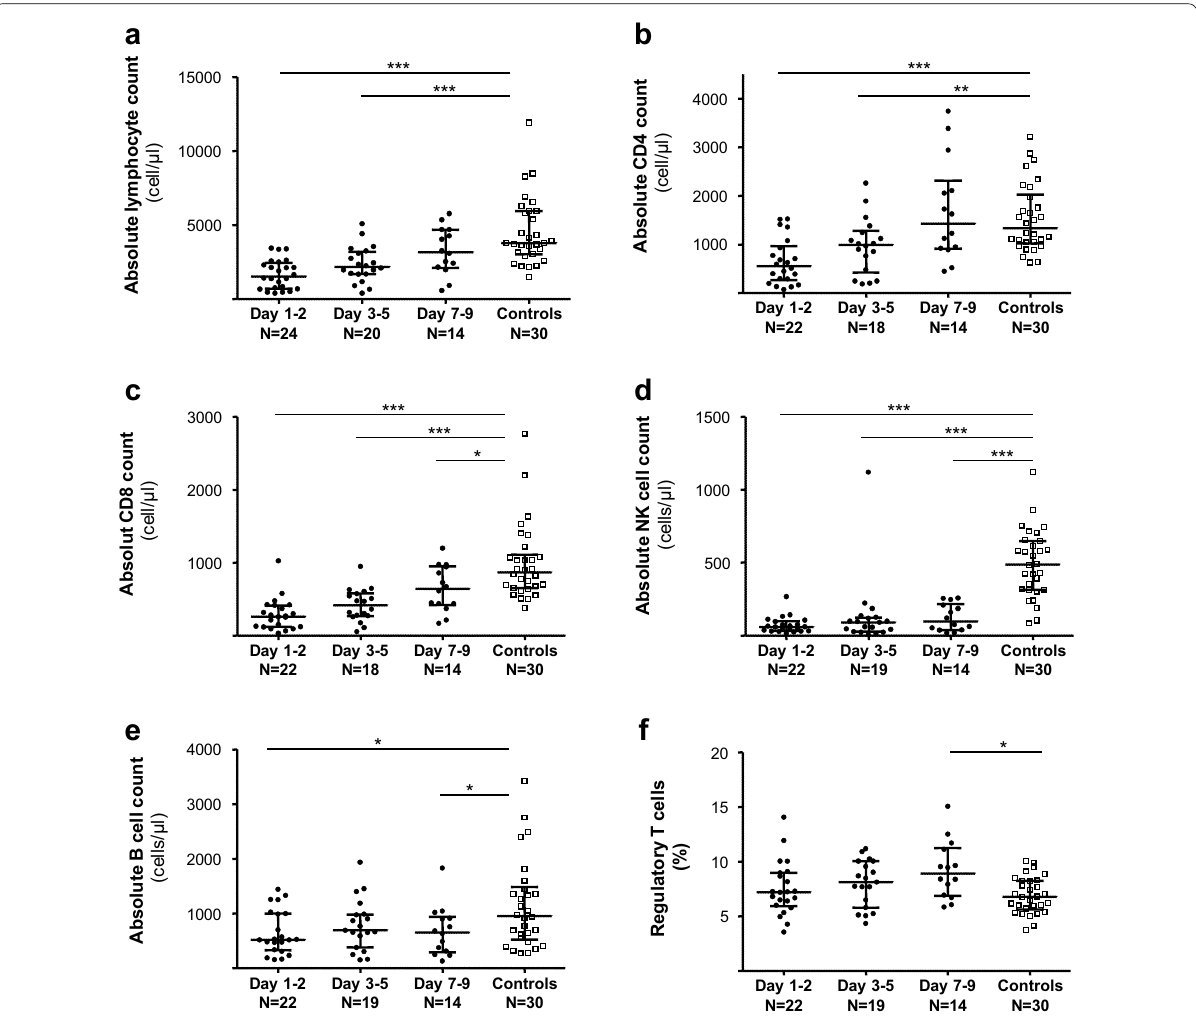
Fig. 3 Time course of lymphocytes’ subsets during septic shock. a Total lymphocytes, b CD4 + T cells, c CD8 + T cells, d NK cells, e B cells (from a to e , results as cell number/µl), f proportion of regulatory T cells (among CD4